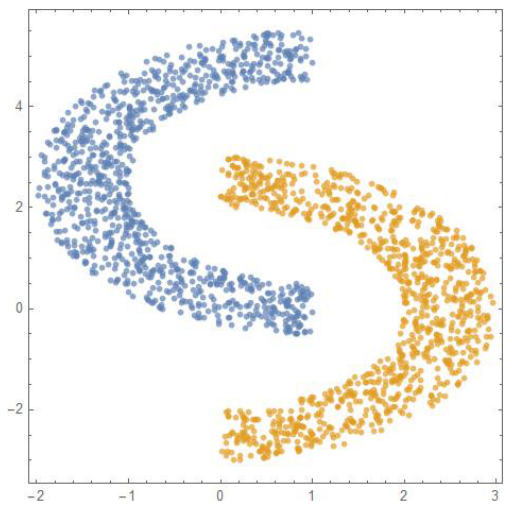
Figure 1. DBSCAN